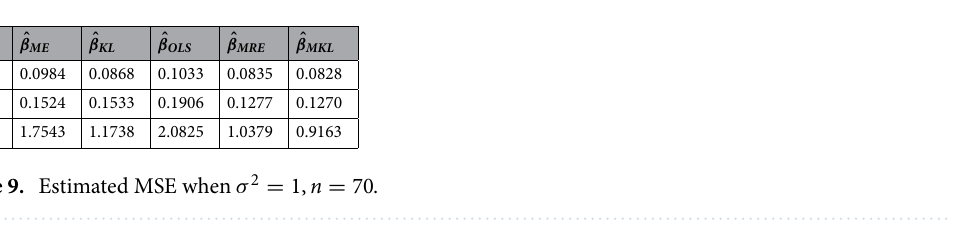
Table 9. Estimated MSE when σ